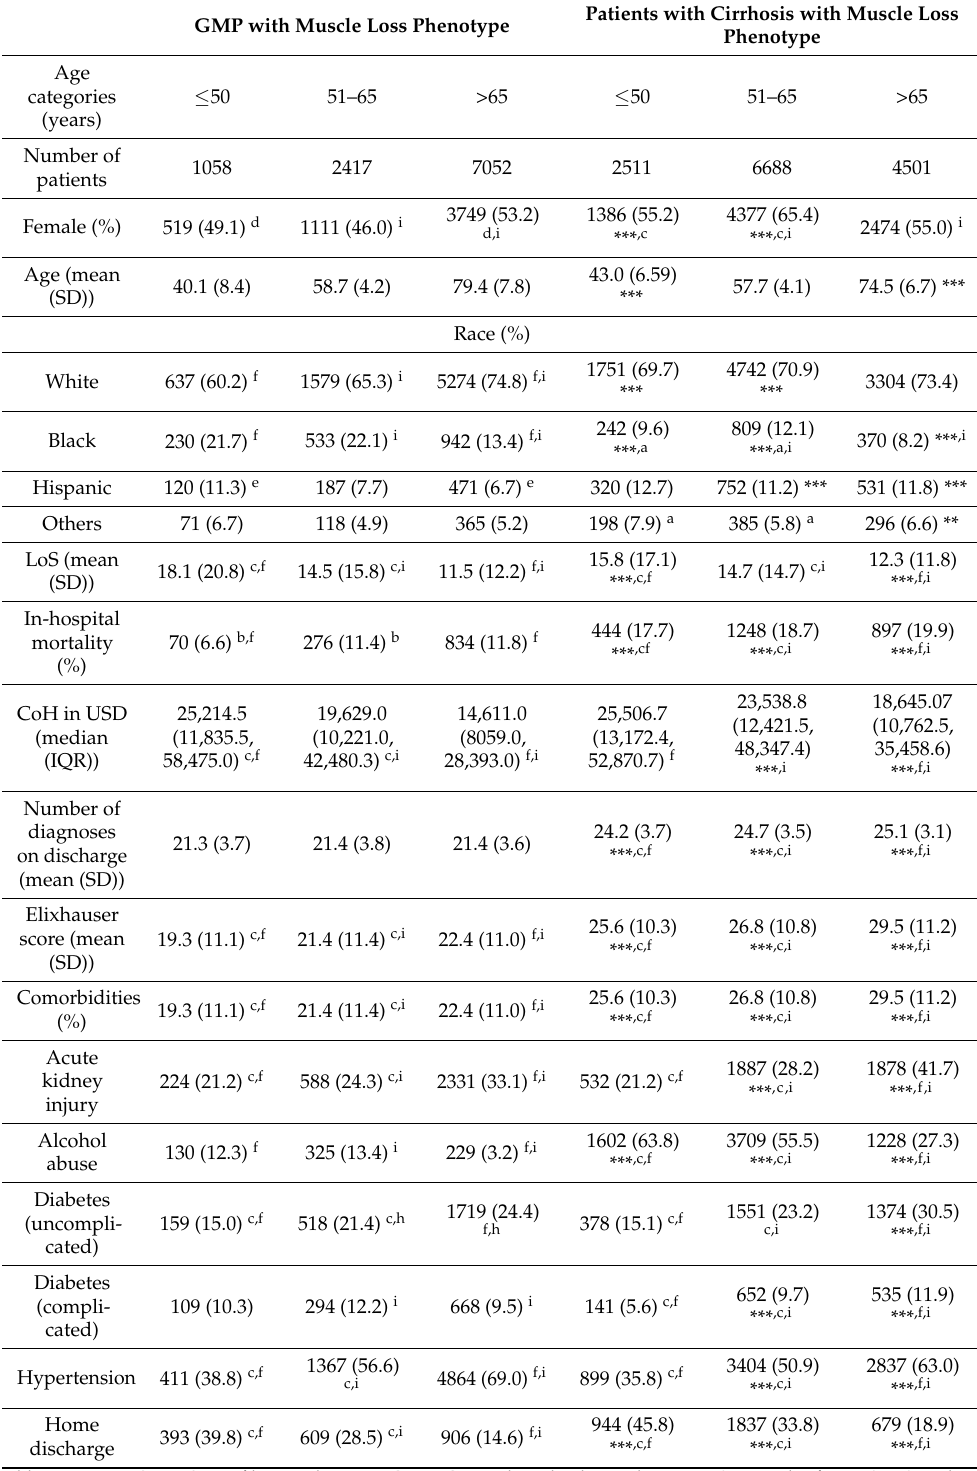
Table 2. Demographic characteristics of hospitalized general medicine population and patients with cirrhosis with muscle loss phenotype, grouped by